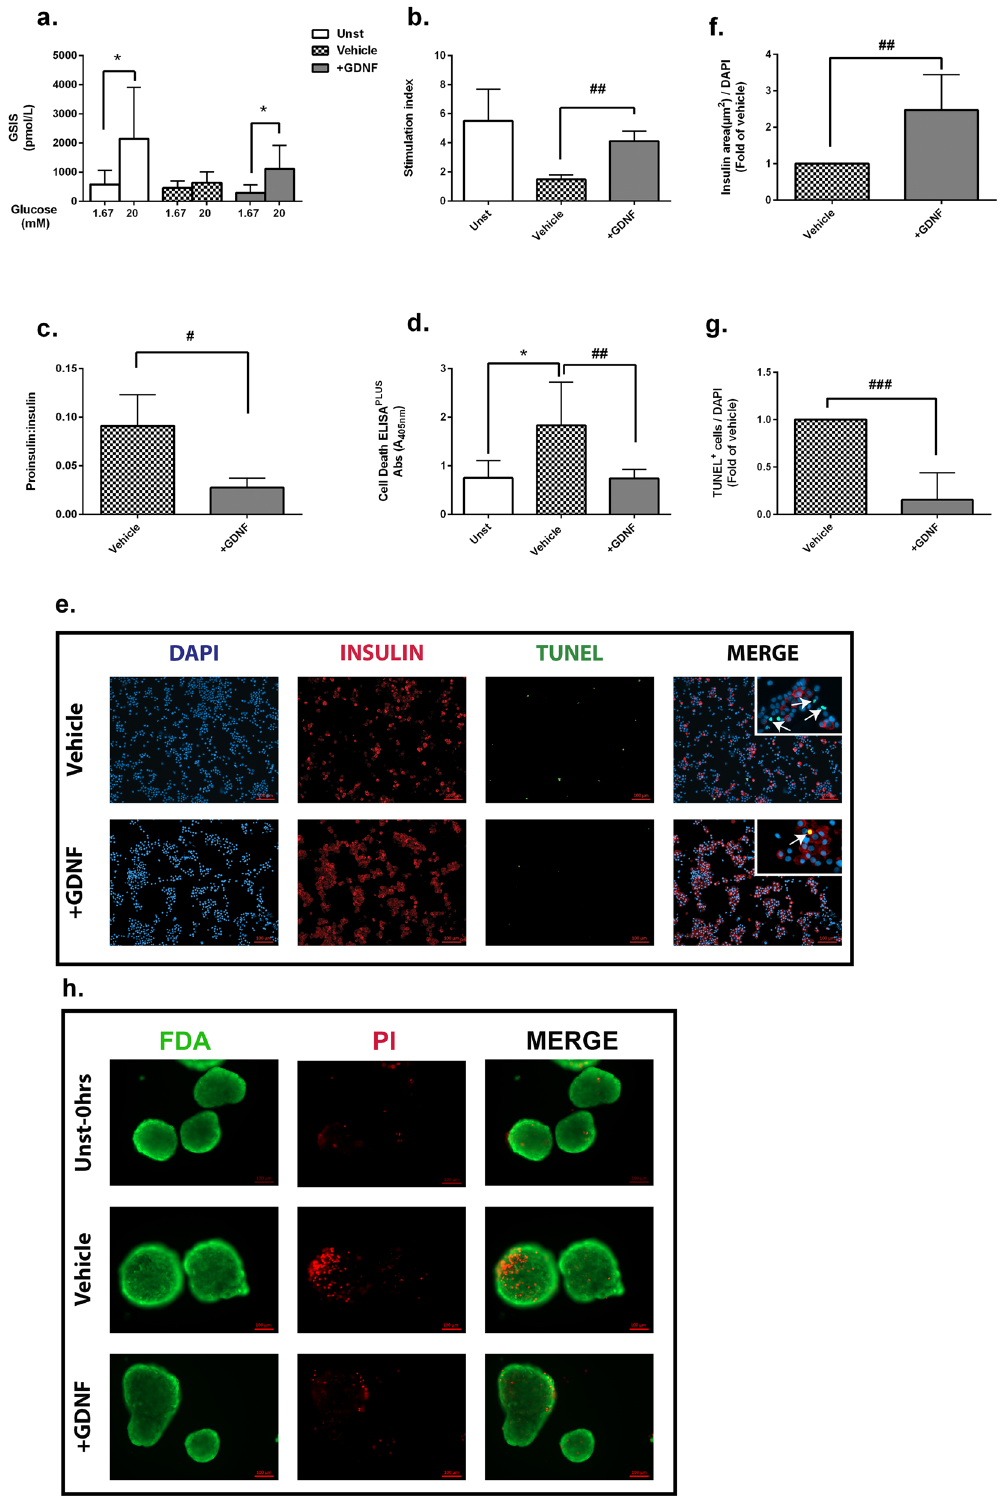
Figure 1. GDNF improves human islets function and viability under nutrient deprived culture condition. ( a ) Insulin secretion in response to basal (1.67 mM) and stimulated (20 mM) level of glucose (GSIS) ( b ) calculated as stimulation index in human islets prior to experiment start (0 hrs, unst islets) and after treatment for 72 hrs with or without GDNF (200 ng/nl) under nutrient deprived culture condition, n = 6. ( c ) Secreted insulin and proinsulin in culture medium were measured by EIA and presented as the proinsulin to insulin ratio, n = 4. ( d ) Apoptosis evaluated by cell death ELISA PLUS in human islets, n = 6. ( e ) Representative images showing insulin (red) and TUNEL (green) with DAPI nuclear staining (blue) of dispersed human islets treated with or without GDNF. ( f ) Ratio of insulin area as well as ( g ) score of TUNEL + cells over nuclear staining. Data is presented as